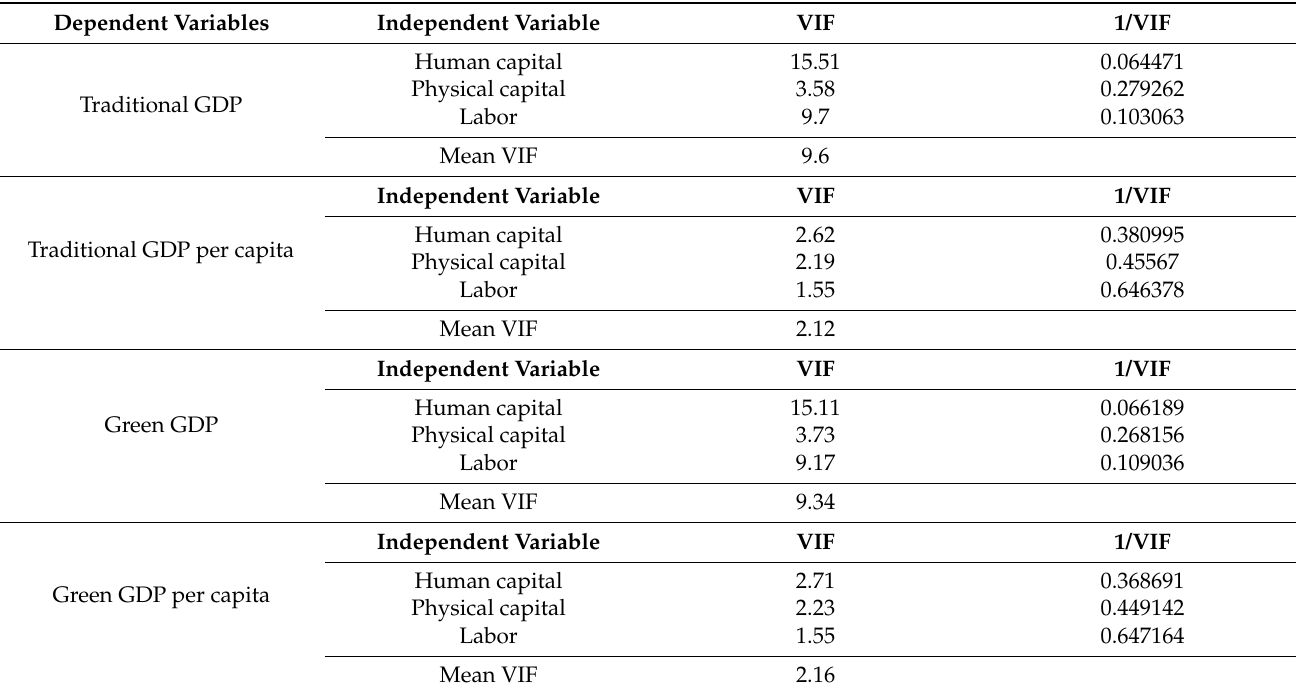
Table 4. Collinearity test for regression models.